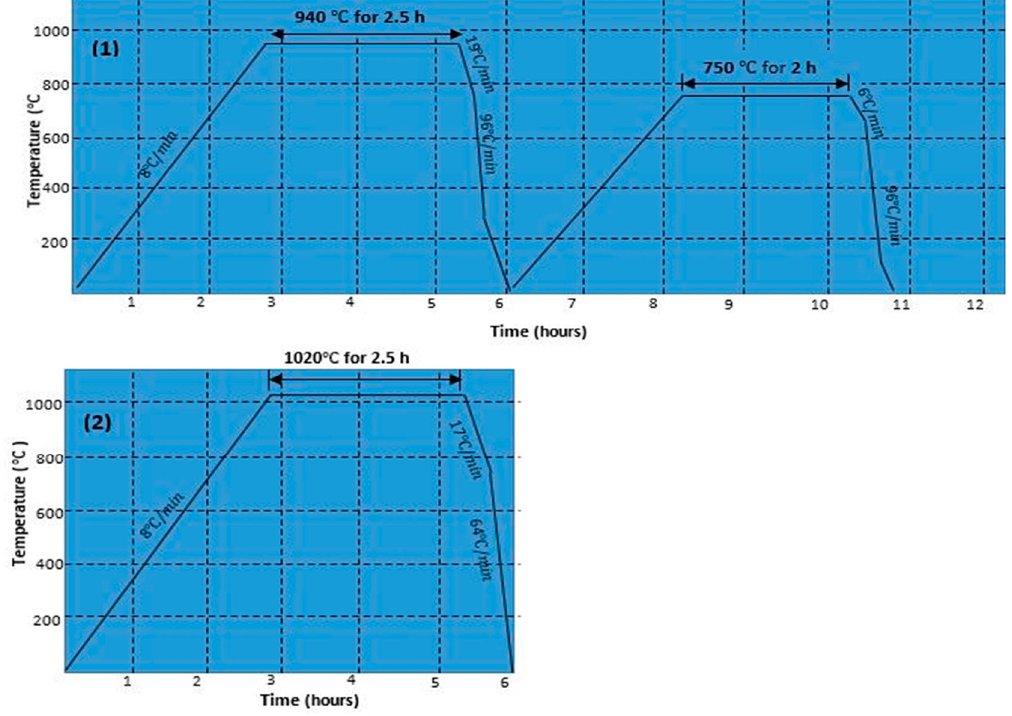
Figure 3. The heat treatment cycles 1 and 2 applied to some of the as-built DMLS Ti6Al4V (ELI)